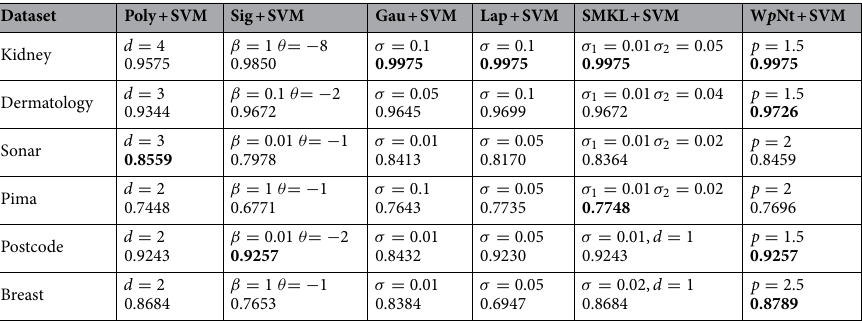
Table 3. The fivefold cross-validation classification accuracy based on the SVM algorithm with different kernel functions. Significant values are in bold.